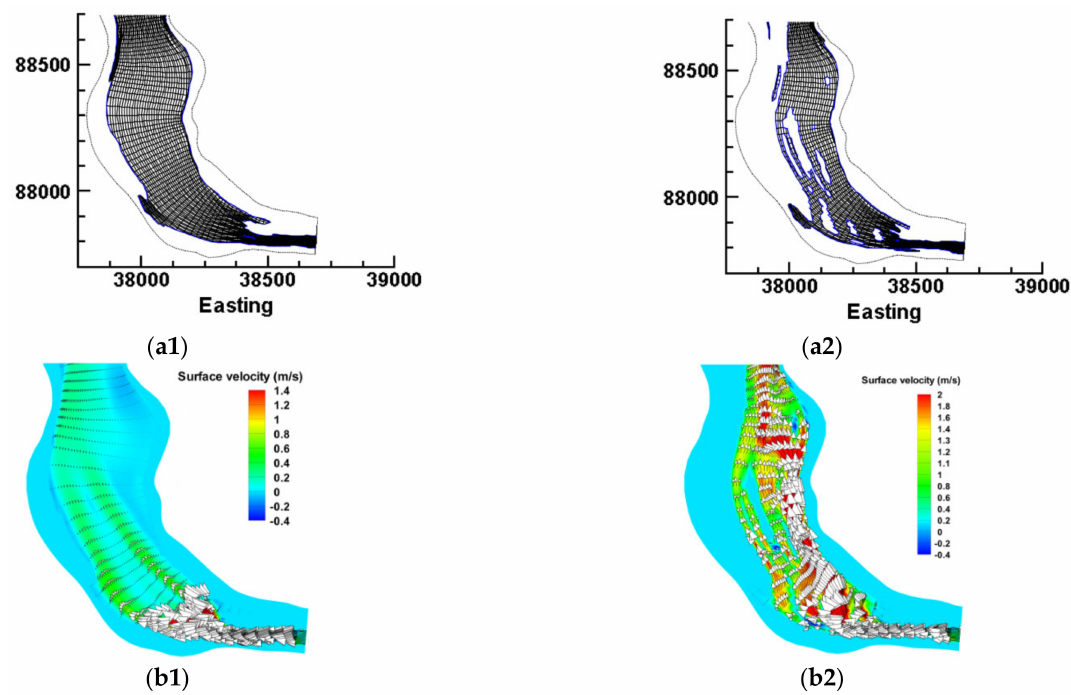
Figure 2. Computational grid of the study segment ( a1 ) at the middle of drawdown (t = 18 h) and ( a2 ) during the free-flow condition (t = 32 h); corresponding surface velocity fields: ( b1 ) at the middle of drawdown (t = 18 h) and ( b2 ) during the free-flow condition (t = 32 h). Vectors show the flow magnitude and